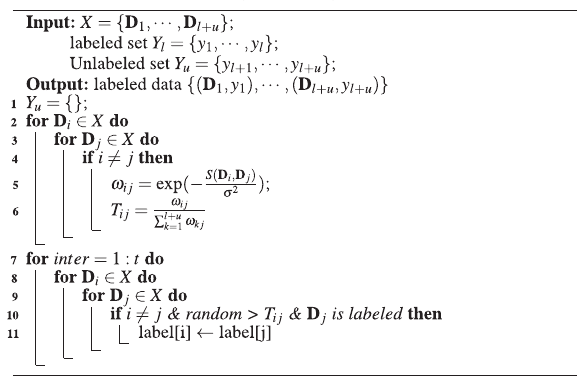
Algorithm 2. Label Propagation Algorithm